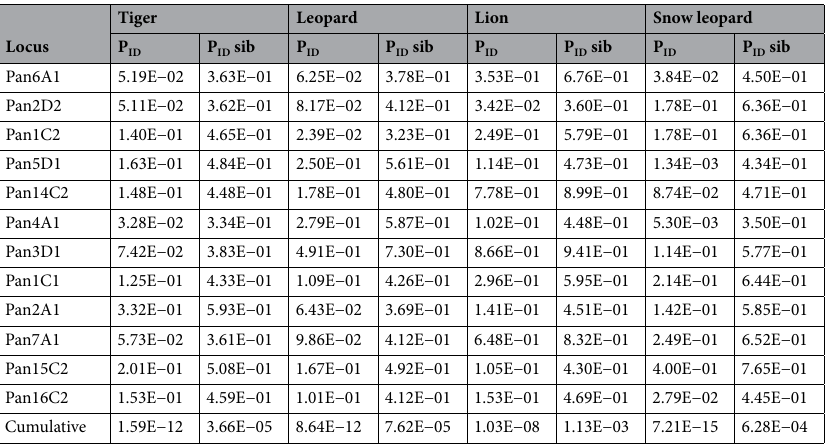
Table 3. Probability of identity for unrelated samples (P ID ) and for full siblings (P ID sib) in 12 microsatellite loci.